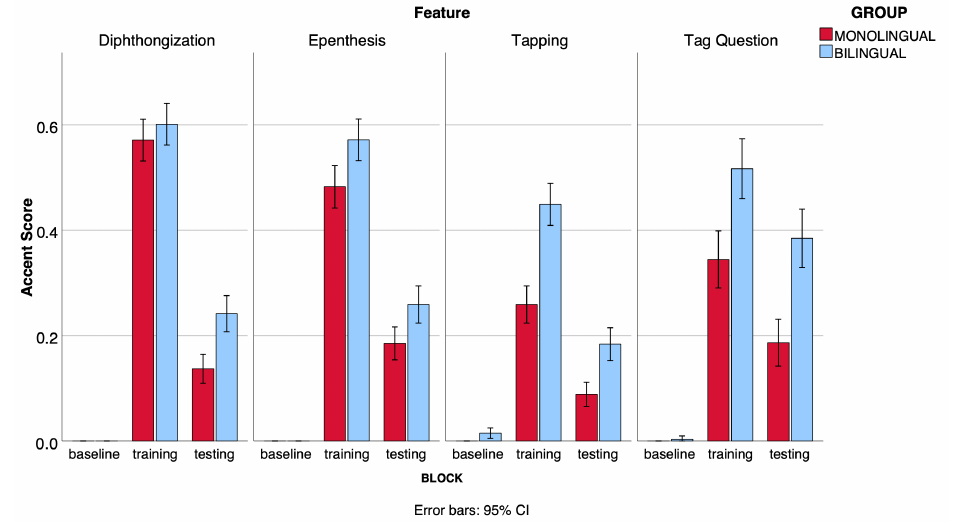
Figure 4. Mean of accent scores for each novel accent feature obtained by monolinguals and bilinguals in Baseline, Training and